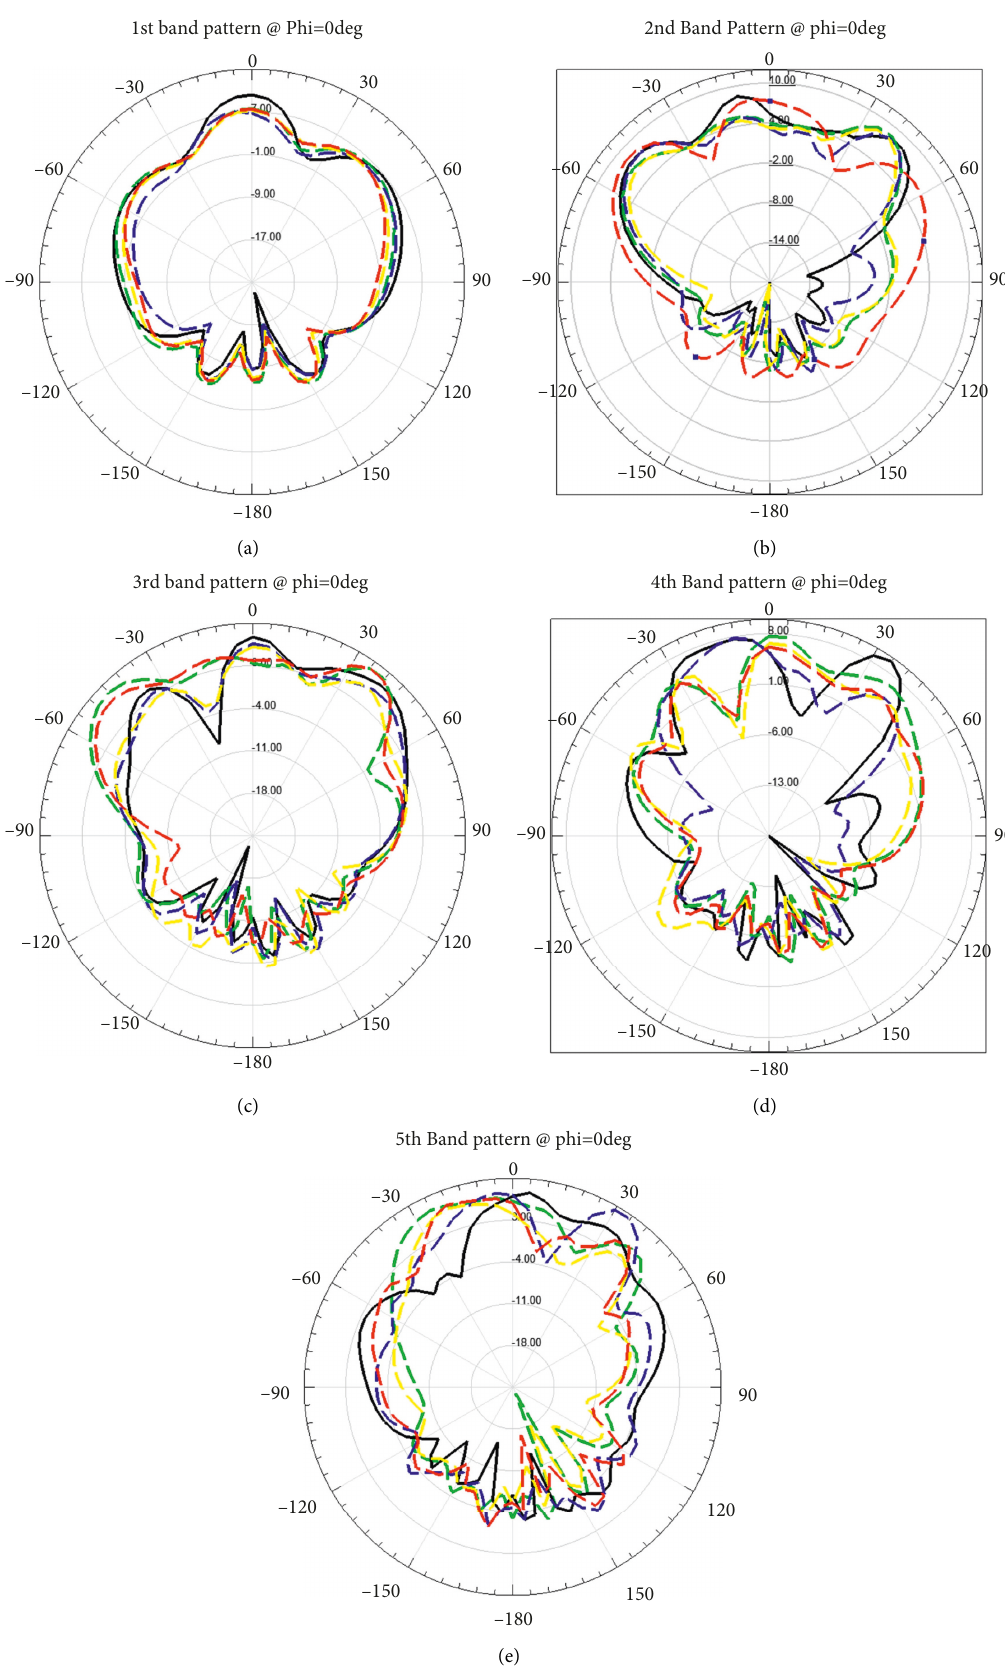
Figure 8: The E-plane gain pattern of the optimized antenna at various fabric